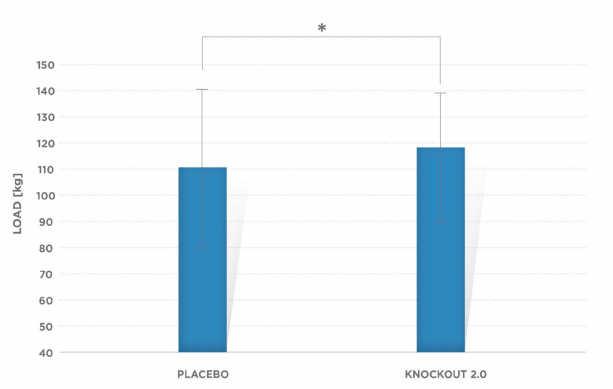
Figure 4. Mean values of 3-RM strength. There were observed significant di ff erence (* p = 0.001) between supplement and placebo conditions. Error bars indicate standard deviation